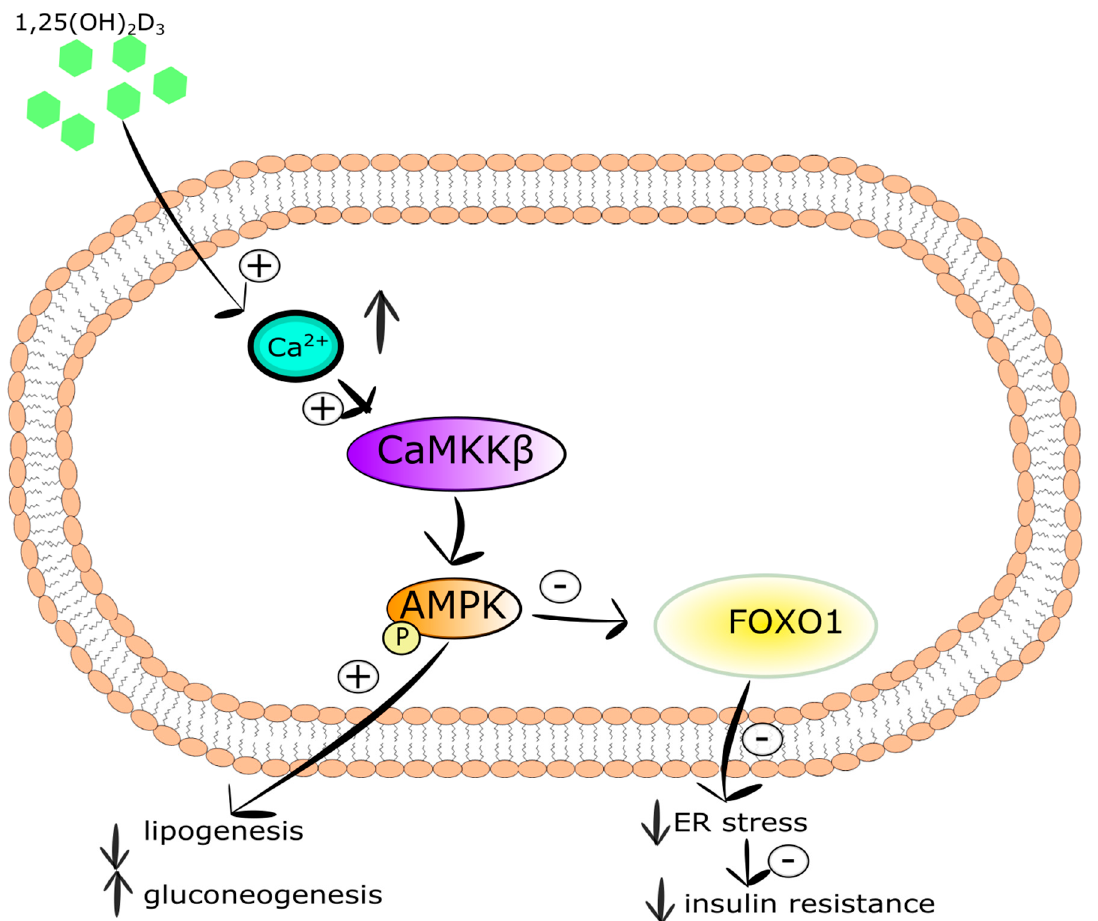
Figure 7. The action of vitamin D in hepatocyte. Stimulatory interactions are indicated by + and inhibition by -; ↓ denotes decrease ↑ denotes increase.